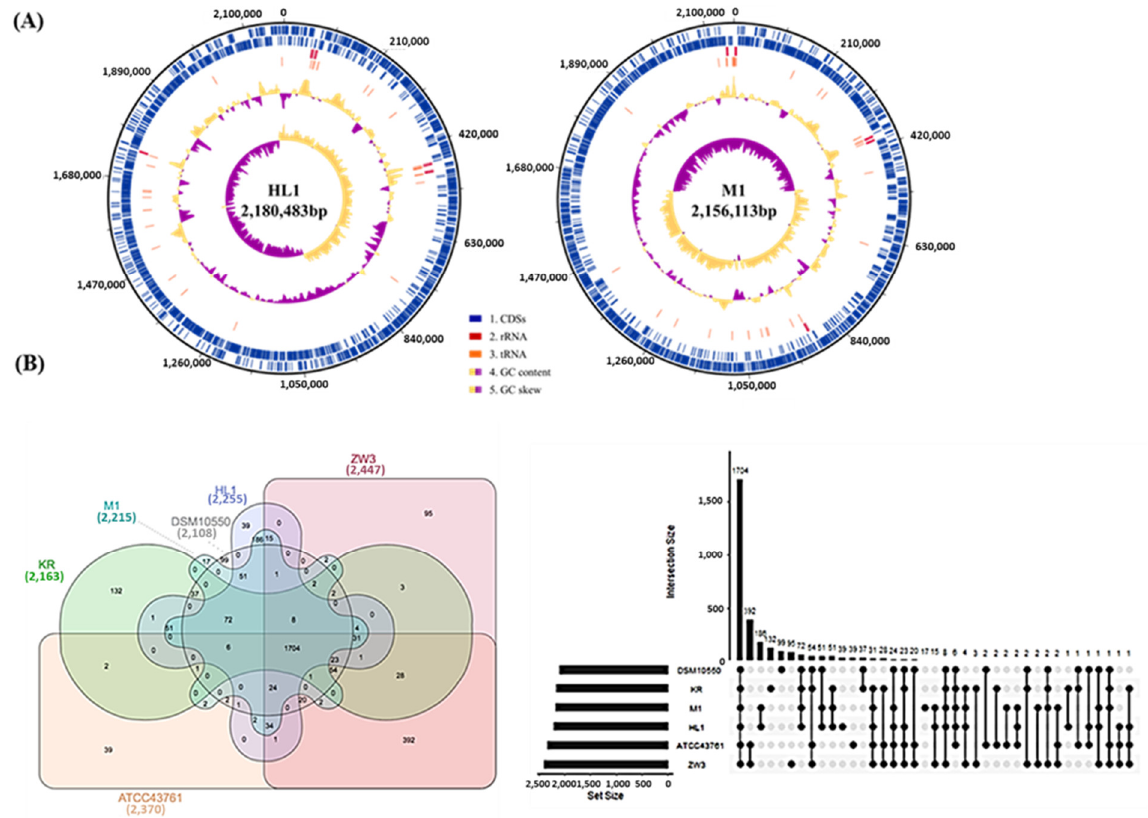
Figure 3. ( A ) Circular genome maps of L. kefiranofaciens HL1 and M1. The six circles (outer to inner) show the following. Circles 1 and 2 demonstrate the CDSs on the forward and reverse strands, respectively. Circles 3, 4, and 5 show the rRNAs and tRNAs and the GC content. Circle 6 represents the GC skew ((C − G)/(C + G)) curve (positive GC skew, orange; negative GC skew, violet); ( B ) Venn diagrams and Upset plot of coding sequences for the six L. kefiranofaciens strains.